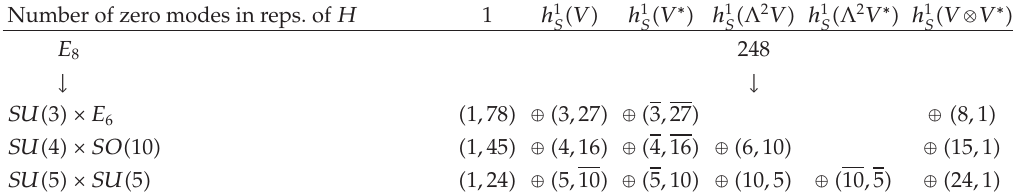
Table 2: Correlation between zero modes in representations of the GUT group H . Number of zero modes in reps. of